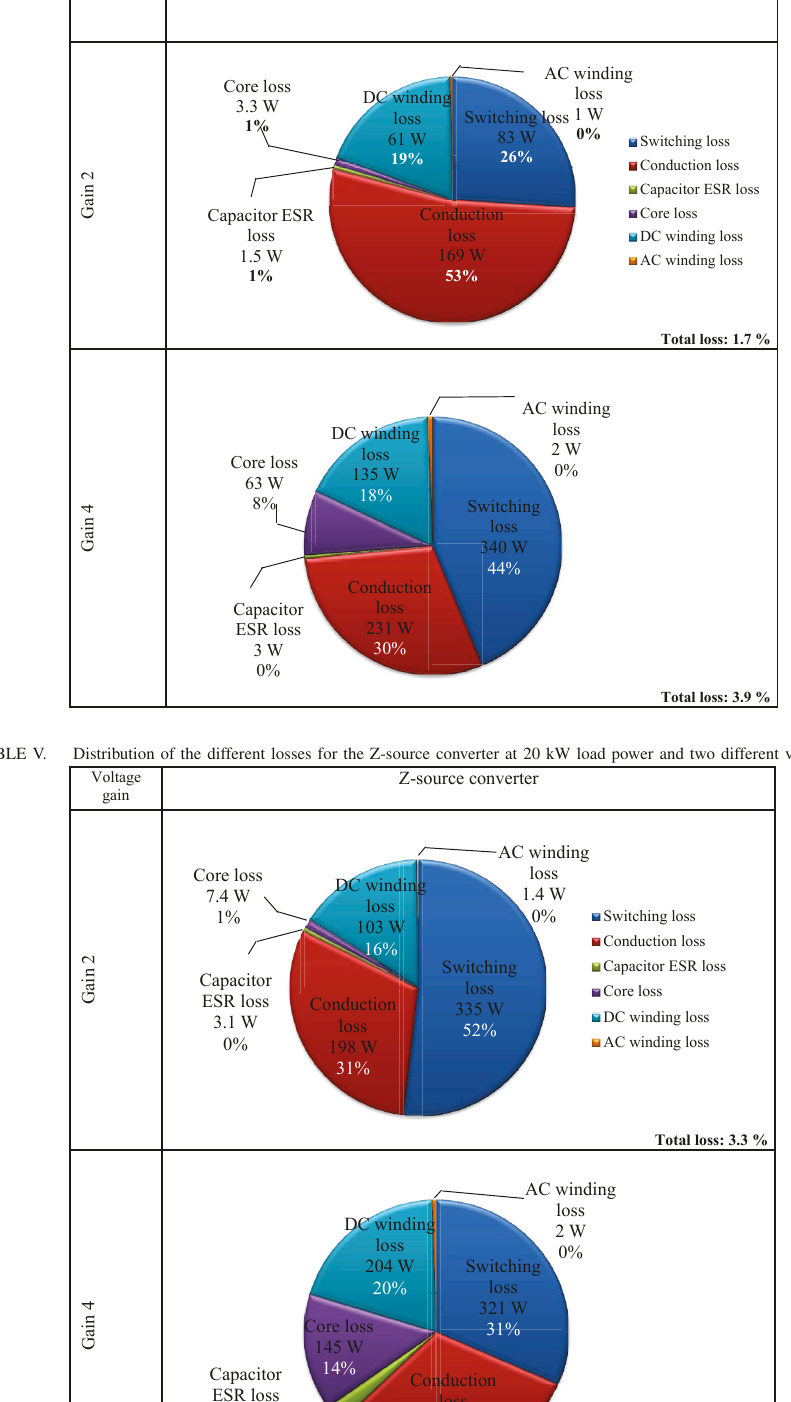
Distribution of the different losses for the Boost converter at 20 kW load power and two different voltage gain. Voltage gain